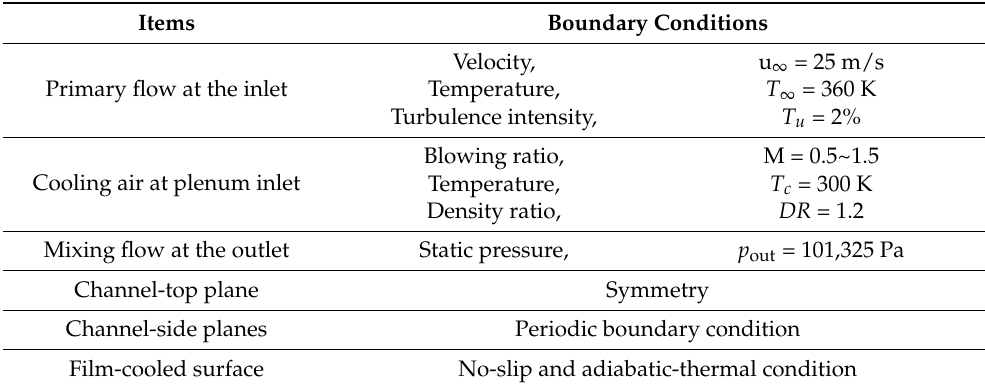
Table 2. Boundary